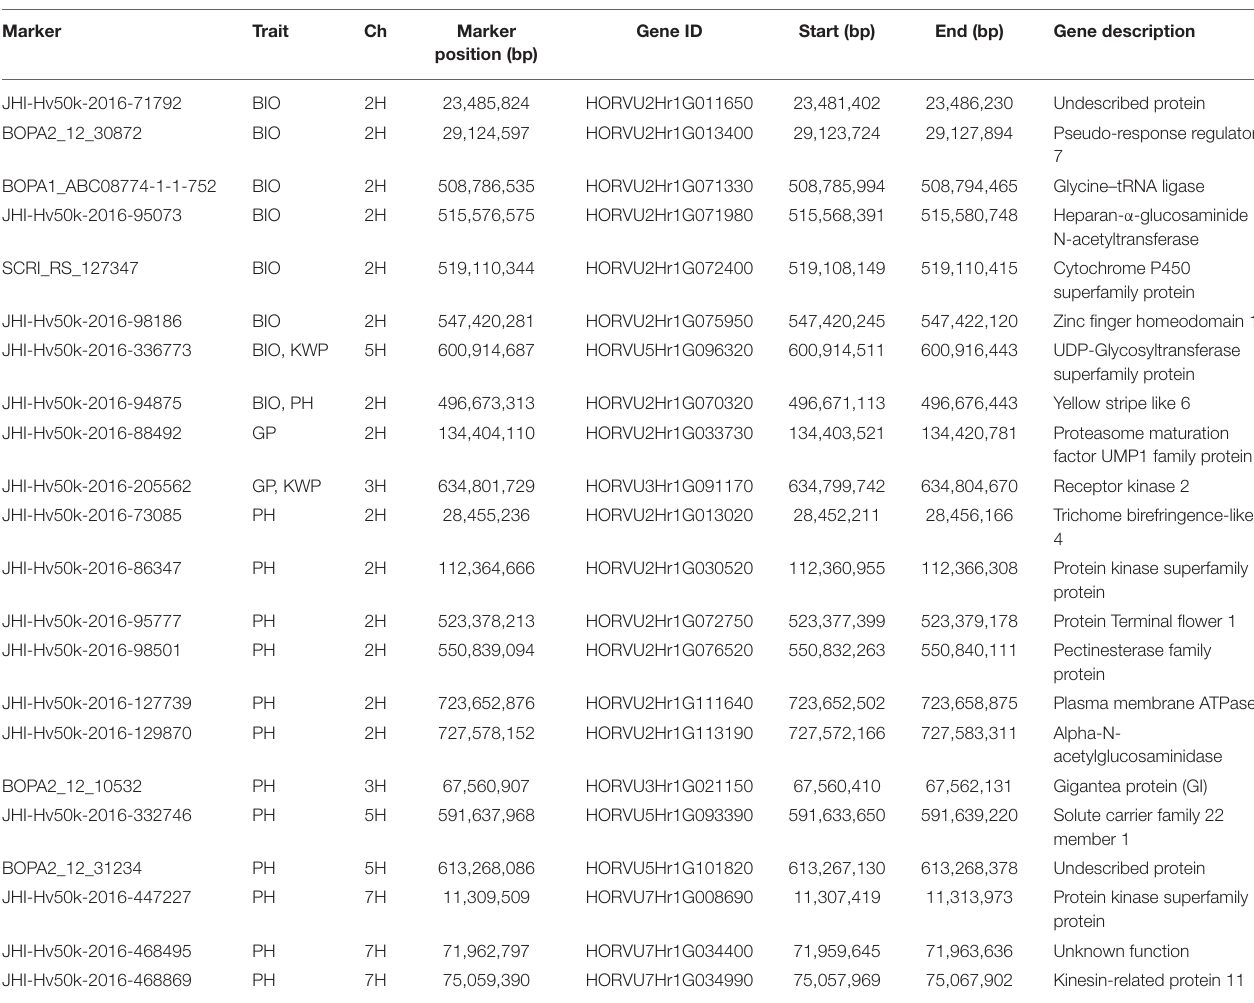
TABLE 6 | Summary of potential candidate genes that contain significant markers associated with the assessed traits under control conditions.